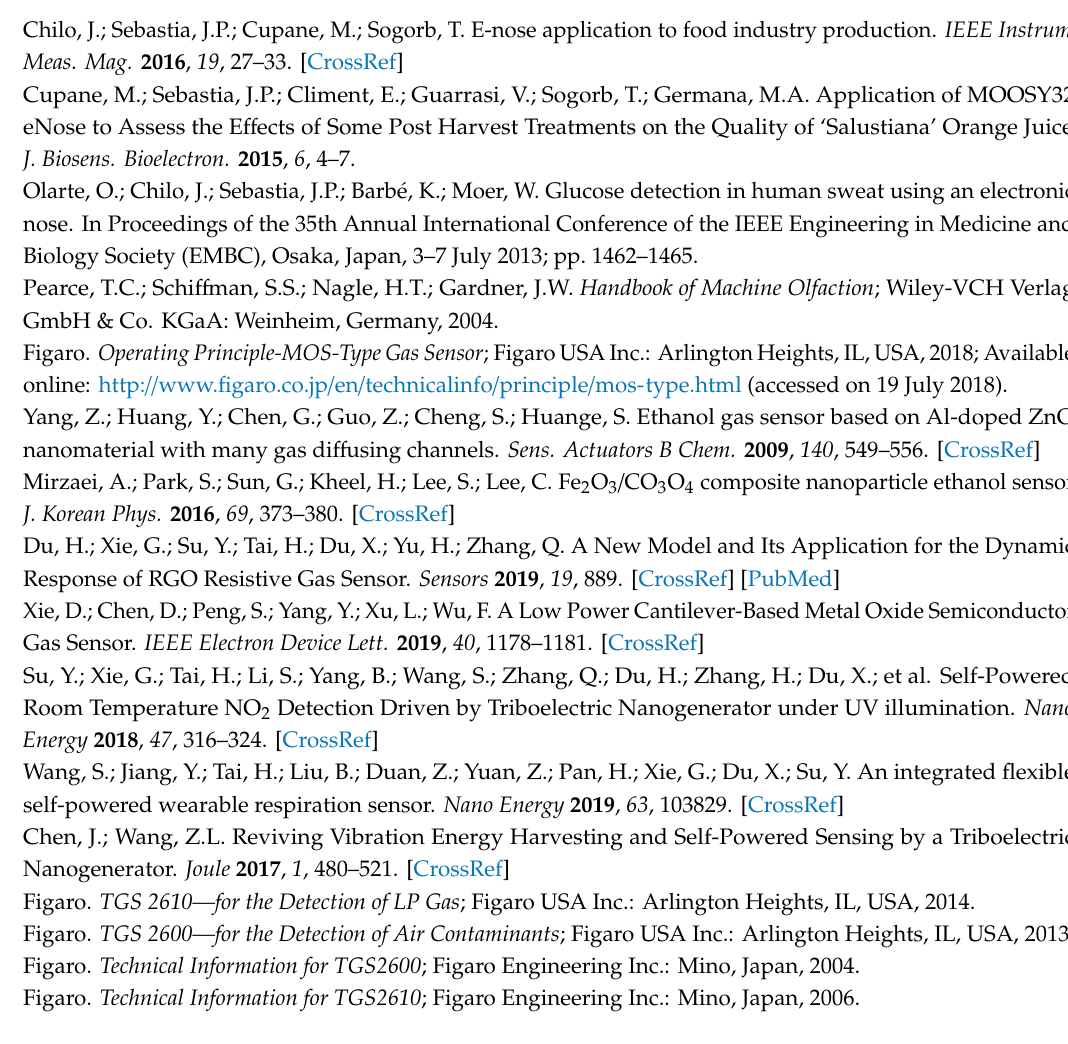
Figaro. TGS 2610—for the Detection of LP Gas ; Figaro USA Inc.: Arlington Heights, IL, USA, 2014. 14. Figaro. TGS 2600—for the Detection of Air Contaminants ; Figaro USA Inc.: Arlington Heights, IL, USA, 2013. 15. Figaro. Technical Information for TGS2600 ; Figaro Engineering Inc.: Mino, Japan, 2004. 16. Figaro. Technical Information for TGS2610 ; Figaro Engineering Inc.: Mino, Japan,